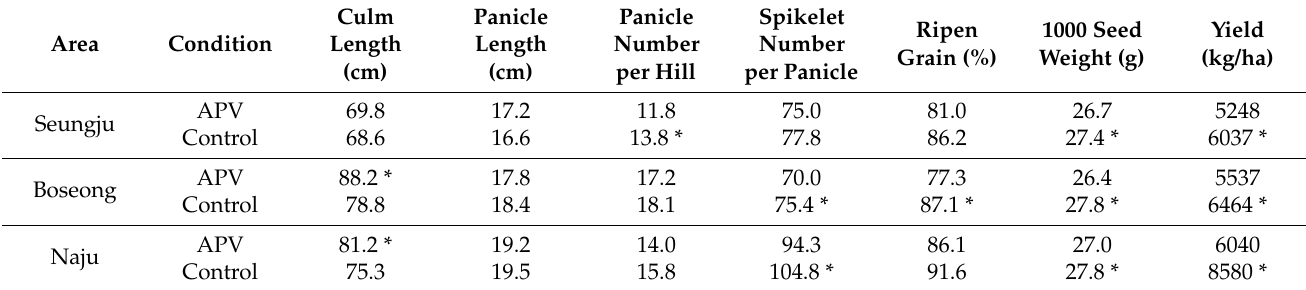
Table 7. Yield of rice underneath agrophotovoltaic (APV) systems in different areas of South Korea.